Question: Provide a one-line summary of what is displayed.
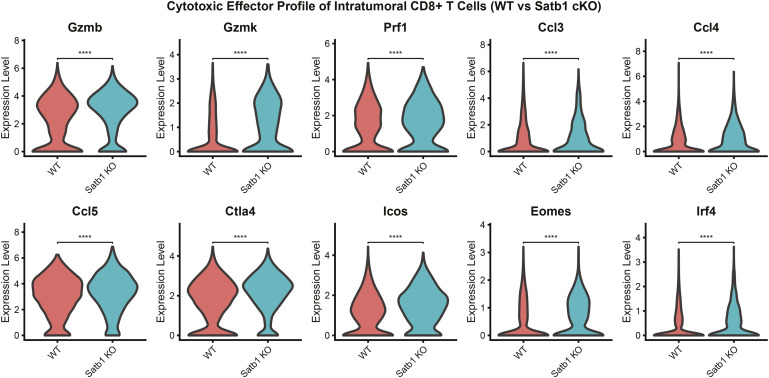
Answer: SATB1 regulates Treg functionality under tumor burden. B16-F10 melanoma cells were subcutaneously injected into hind right flanks of WT and Satb1 F/F : Thpok-cre mice. About 2 wk later, mice were euthanized for the analysis. The summary graph shows the weights of spleens and numbers of splenocytes (A) and the tumor sizes (B) with mice with indicated genotypes (n = 7). Error bars indicate mean ± SD and each dot represents a mouse examined over at least two independent experiments. Statistical significance is measured via unpaired two-tailed t tests for Day 14 points. Flow cytometry analysis for CD44/CD62L, PD-1/Tim3, or IFNγ/TNFα (intracellular staining) from the splenic, tumor-draining lymph nodes, or TILs of TCRβ + CD4 + FoxP3 + CD25 + (C), TCRβ + CD4 + FoxP3 − CD25 − (E), and TCRβ + CD8 + T cells (F) are shown. (D) Intratumoral Treg cells were purified and subjected to suppression assay. The suppressor and responder cell ratios were 1:1. A summary graph of duplicates from two mice is shown on the right. (G) IFNγ and TNFα of intratumoral CD8 + T cells were intracellularly stained. A summary graph of duplicates from two mice is shown on the right. One representative profile from more than three independent experiments is shown as dot plots. Numbers in the dot plots indicate the percentage of cells in each quadrant. Statistical significance is measured via unpaired two-tailed t tests and is presented as follows: n.s. nonsignificant, * P < 0.05, ** P < 0.01, *** P < 0.001.